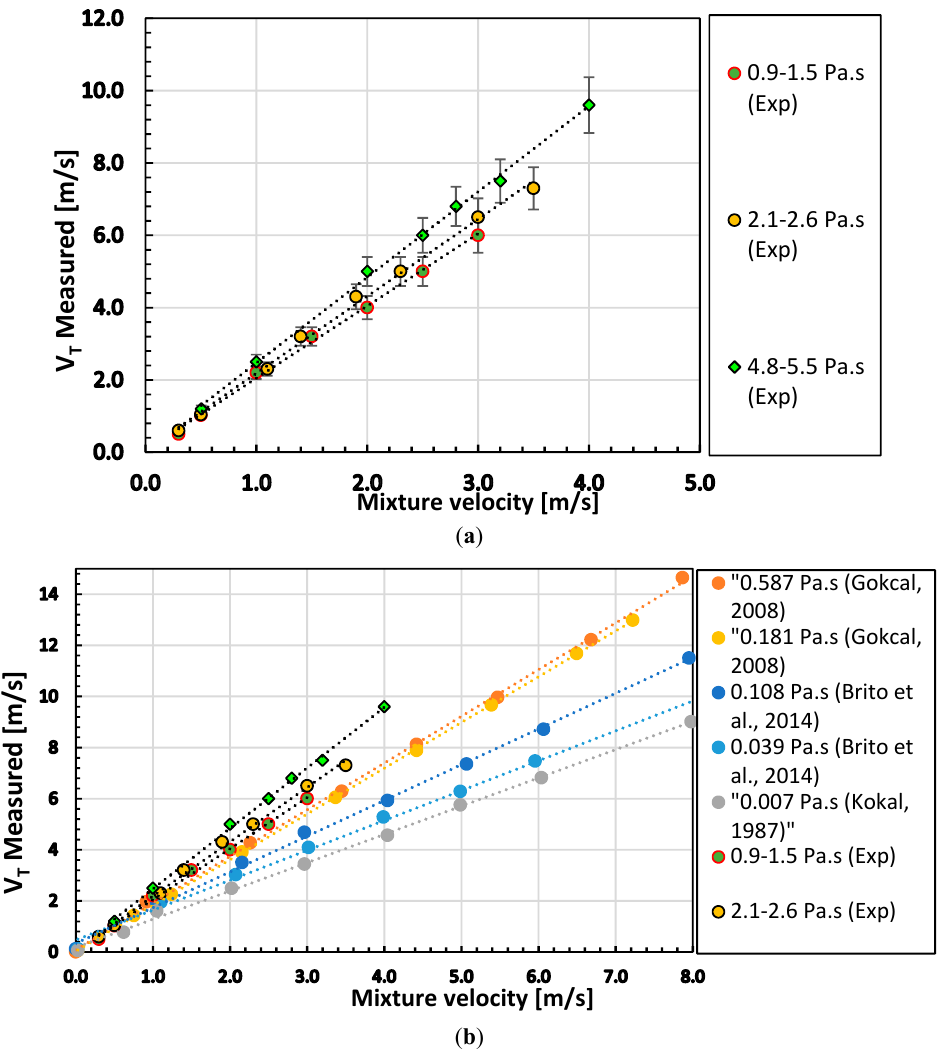
Figure 7. ( a ) Data from this work and ( b ) slug translational velocity vs mixture velocity for data from this work compared with previously reported at different flow conditions (Vsg = 0.3–7.0 m/s and Vsl = 0.2–0.4 m/s).